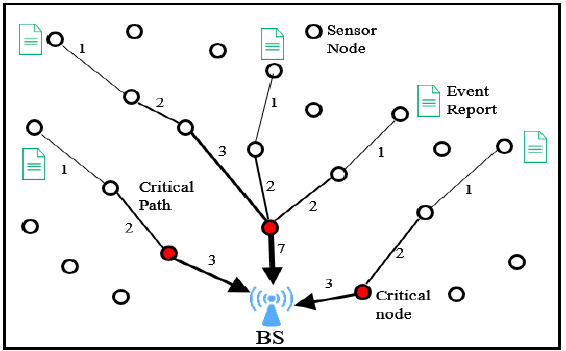
Figure 1. An illustration of the hot-spot